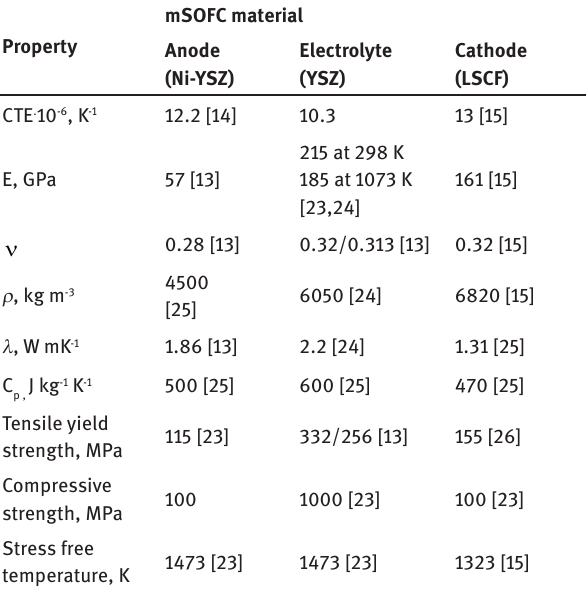
Table 1: Mechanical properties of mSOFC layer materials.